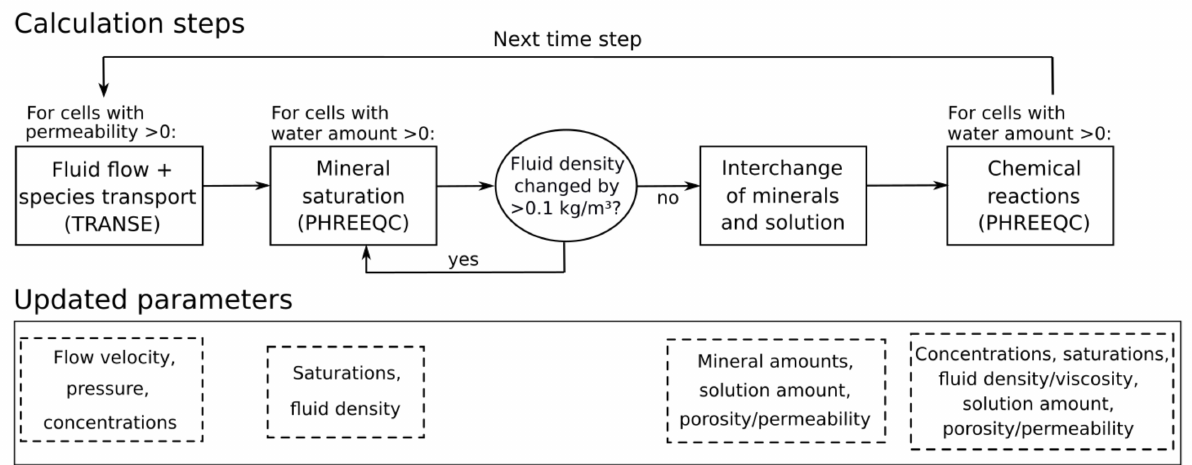
Figure 1. Flow sheet of the coupled reactive transport model: calculations undertaken at each simulation time step and associated output parameters (modified from Steding et al.